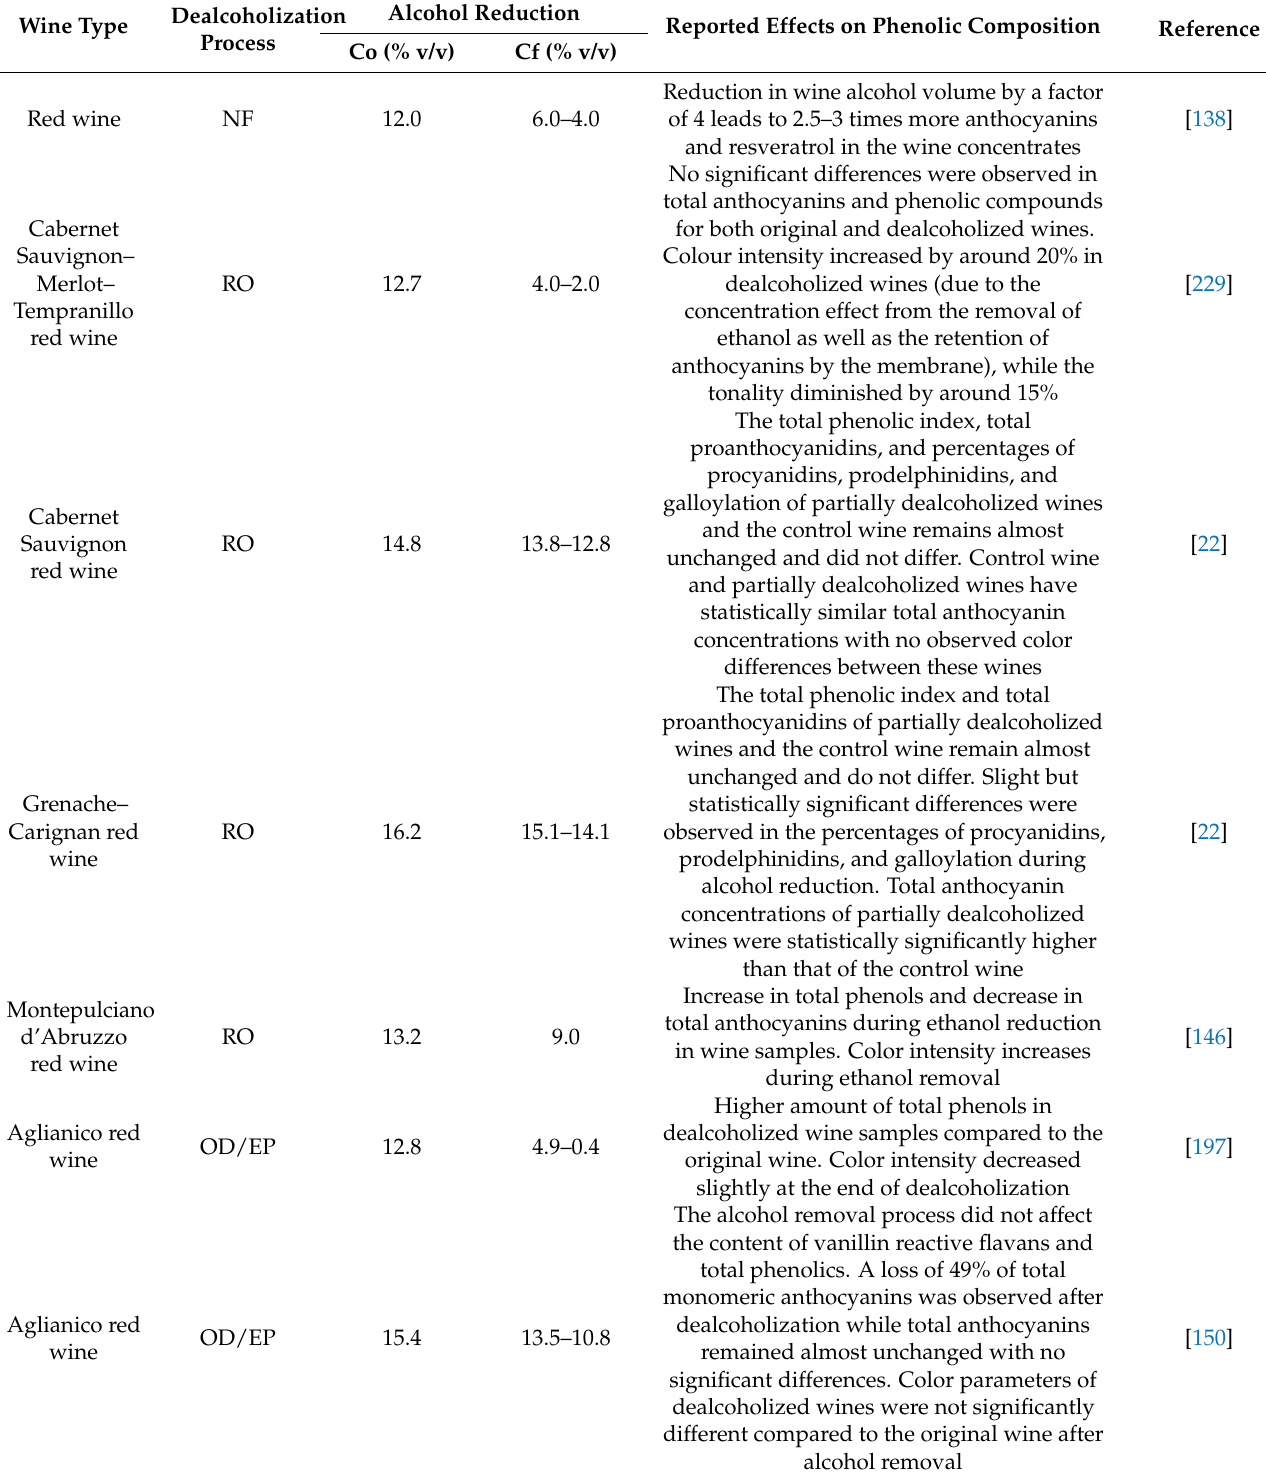
Table 2. Some reported changes in wine phenolic compounds using different dealcoholization